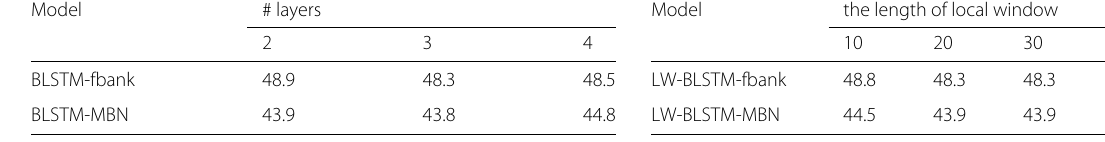
Table 4 BLSTM accuracy as a function of the number of layers Model